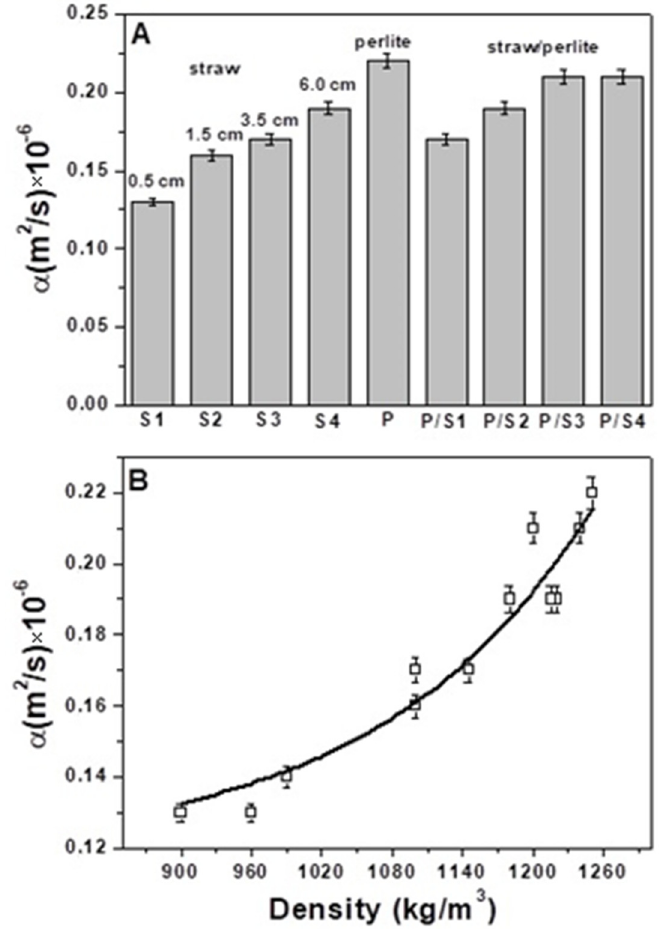
Figure 5. ( A ) Thermal diffusivity of the specimens with the same volume of aggregates (400 mL). ( B ) Exponential increase in the thermal diffusivity with density increase. Table 2. Density and porosity of the mortars.